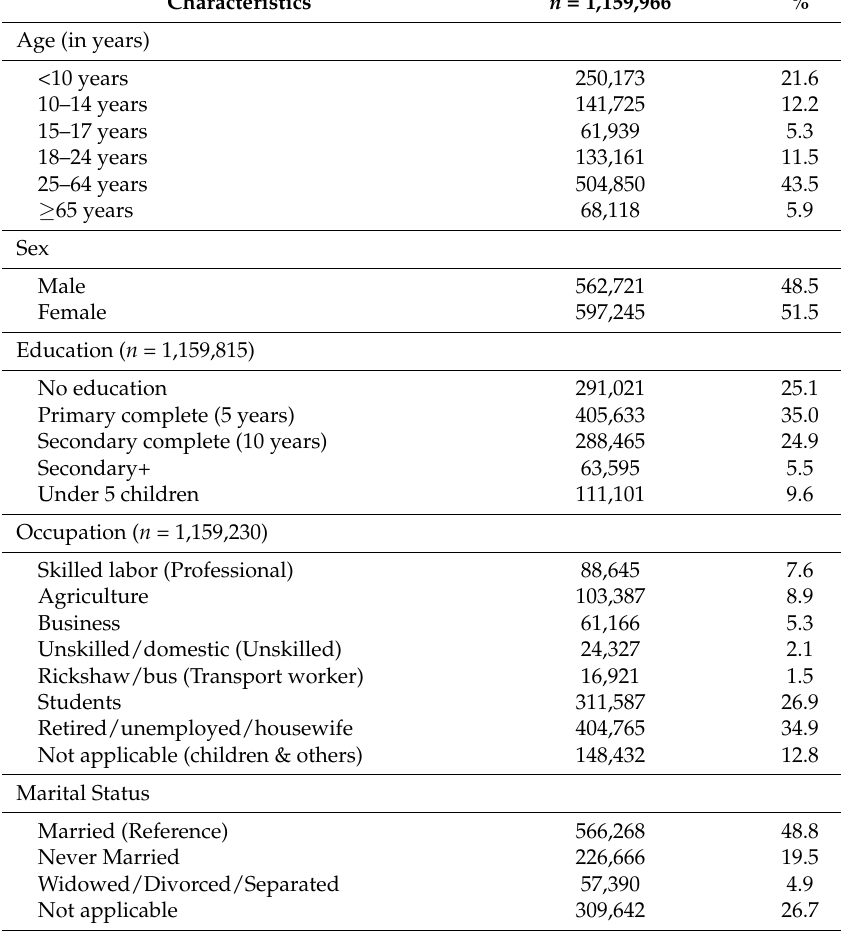
Table 1. Socio-demographic characteristics of the rural population from seven sub-districts of Bangladesh, 2013. Characteristics n =